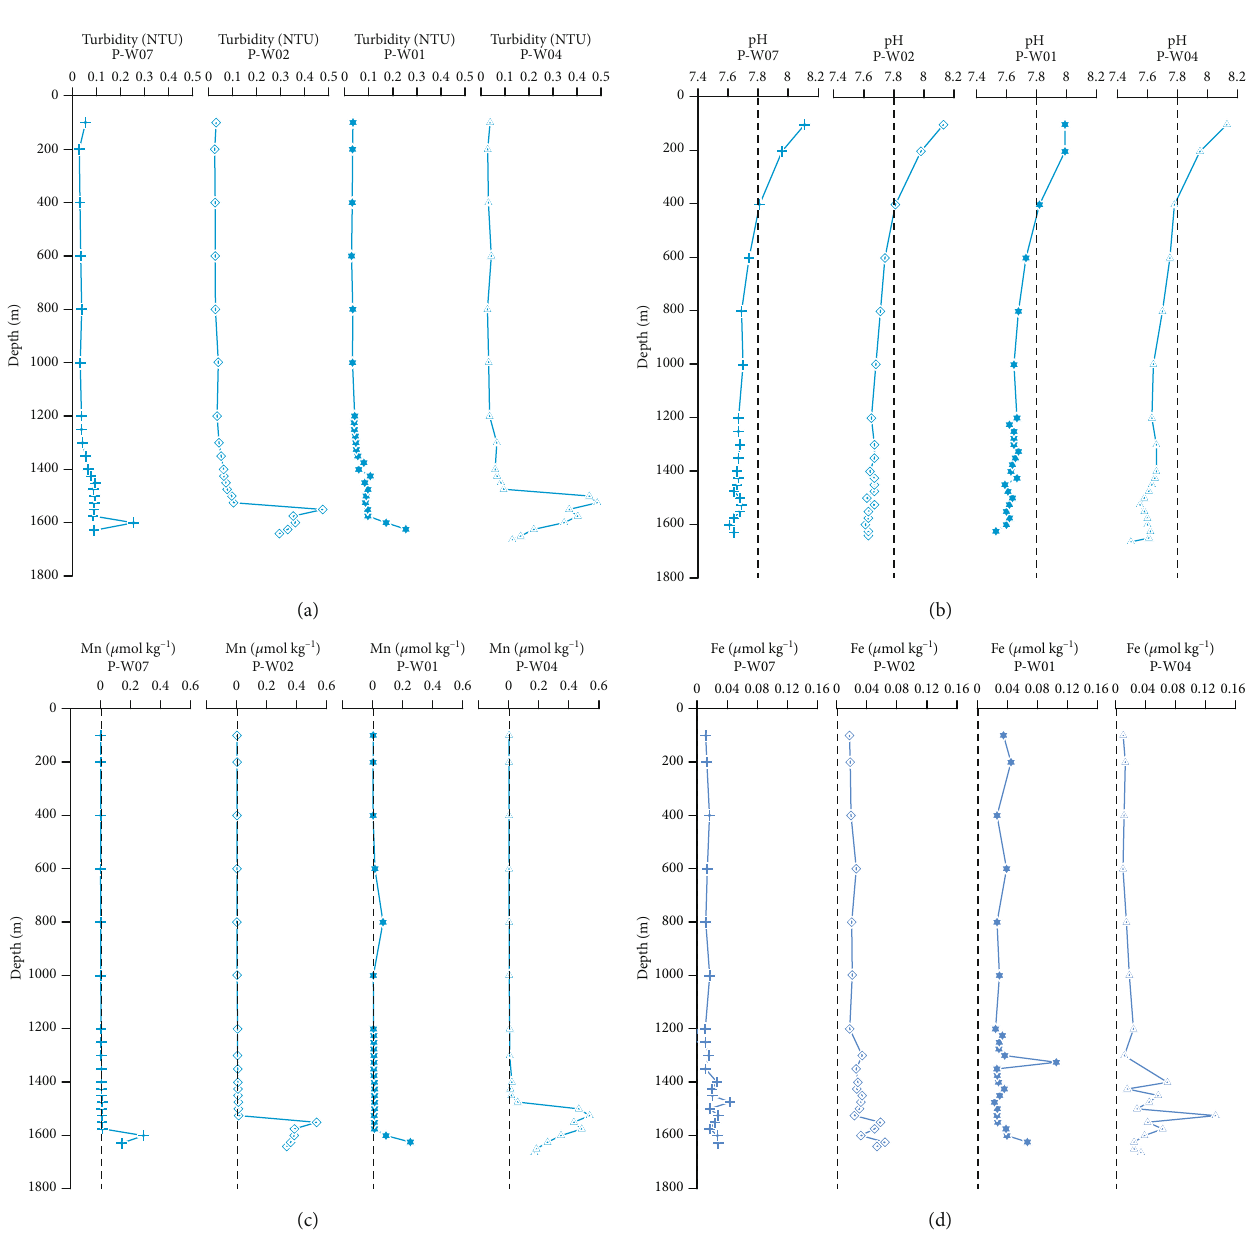
Figure 2: (a) Turbidity, (b) pH, (c) Mn, and (d) Fe anomalies in the water columns at the PACMANUS hydrothermal fi eld (stations P-W07, P-W02, P-W01, and P-W04). The seawater composition (vertical dashed line) was obtained from Seewald et al. [31] and Douville et al.